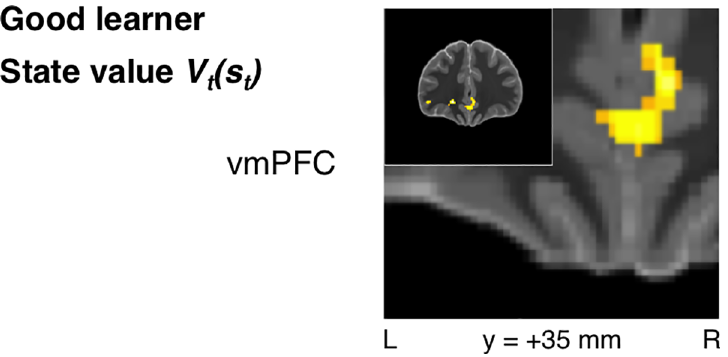
Fig 7. Good-learner group: State-value signals. State-value signalswere similarlyidentifiedin vmPFC when focusingon the Good-learner group alone ( p < 0.005 unc., SVC p FWE < 0.05).